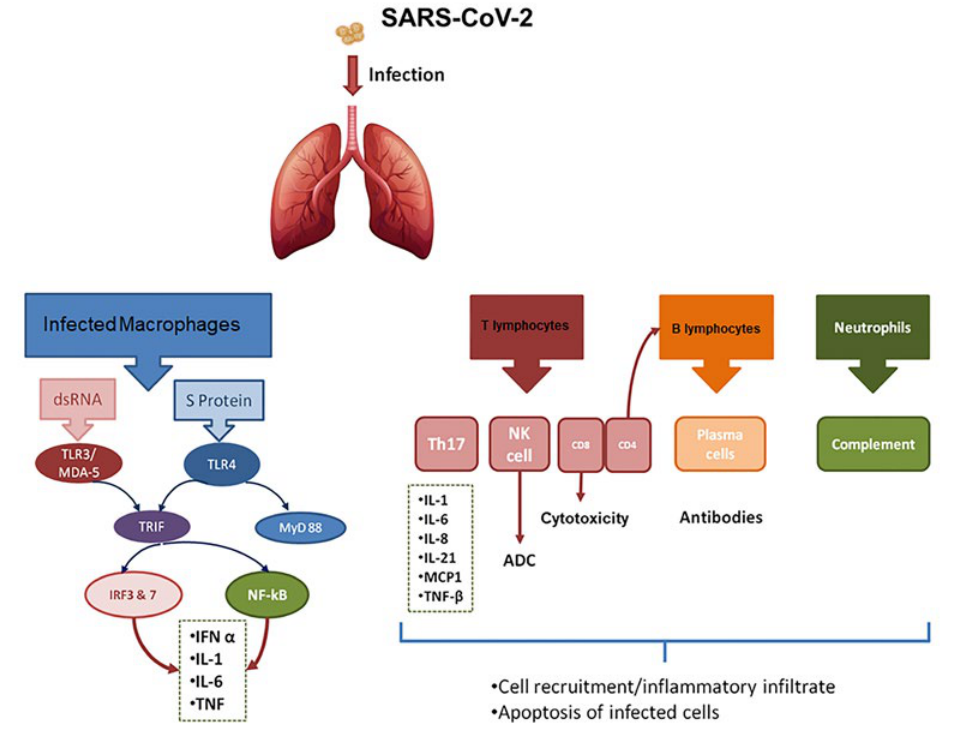
Figure 4- Diagram of the immune response to infection with